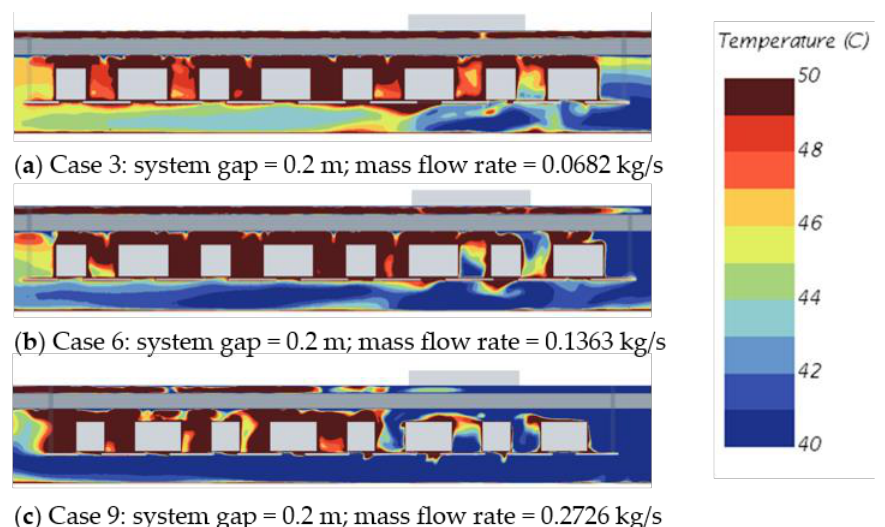
Figure 17. Air temperature contour for Cases 3, 6, and 9 of the underfloor equipment bay (Configuration 2) when radiative effects are dominating.